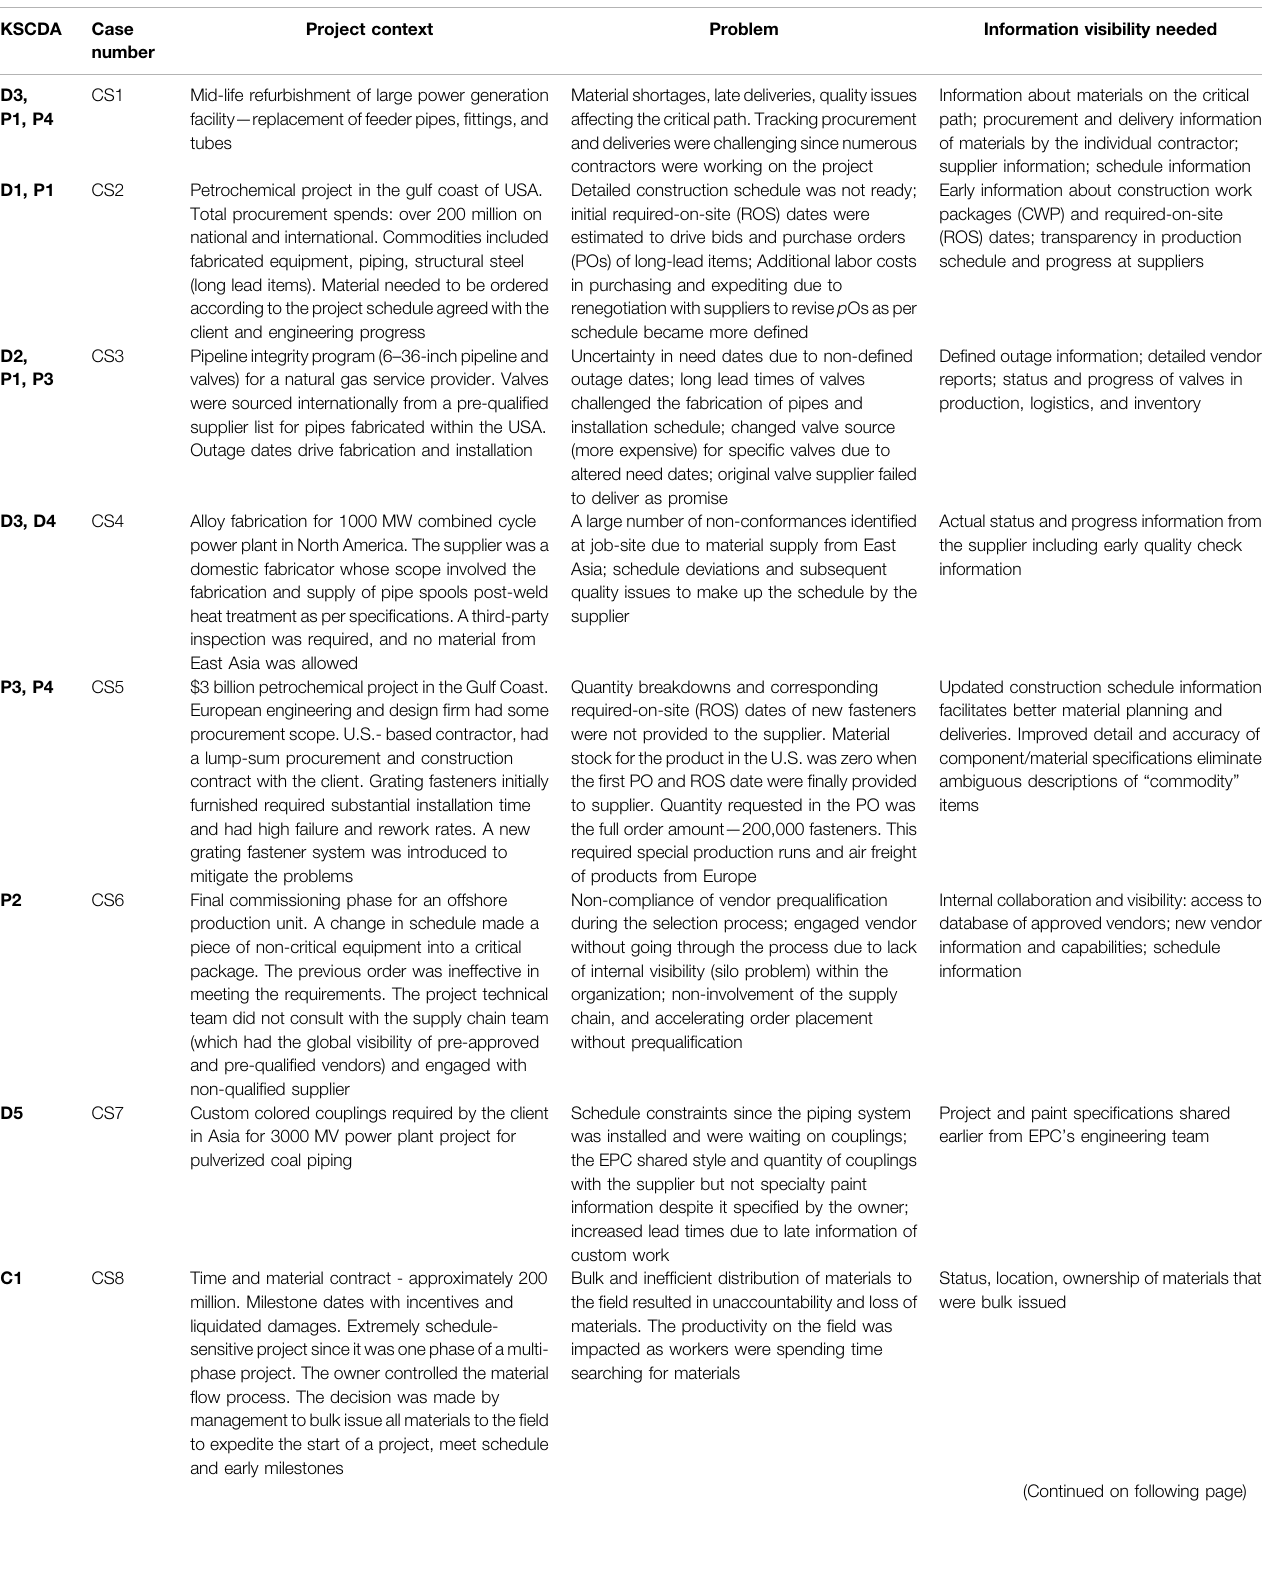
TABLE 4 | Summary of case studies supporting information needed for key supply chain